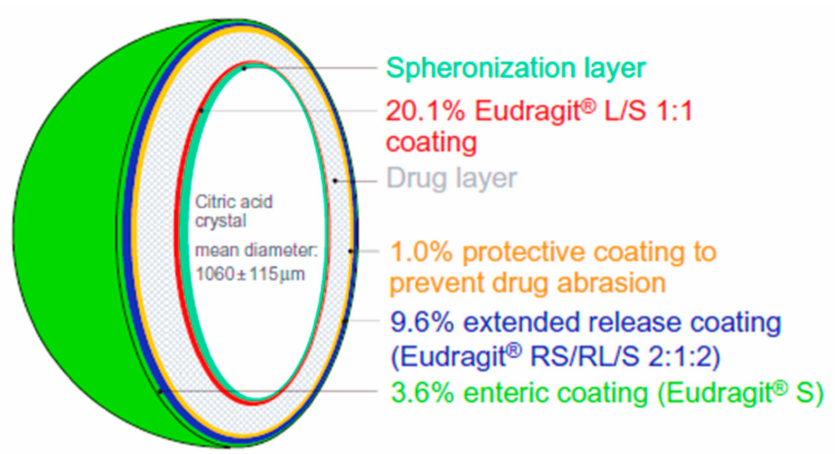
Figure 8. Illustration depicted the formulation principle of membrane-coated multiple units extended release pellets. Reprinted with permission from ref [60]. Copyright 2009 Taylor &